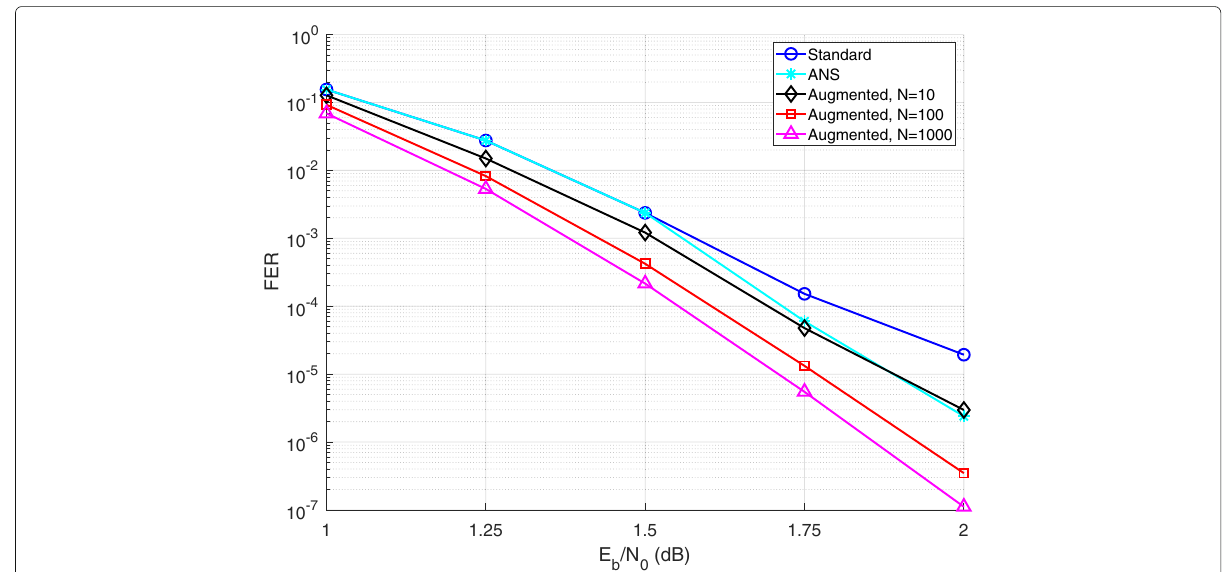
Fig. 8 802.11n FER plot. FER performance of augmented decoders for the n = 1944 and R = 1 / 2 802.11n code. Also shown is the performance of a ANS serial decoder